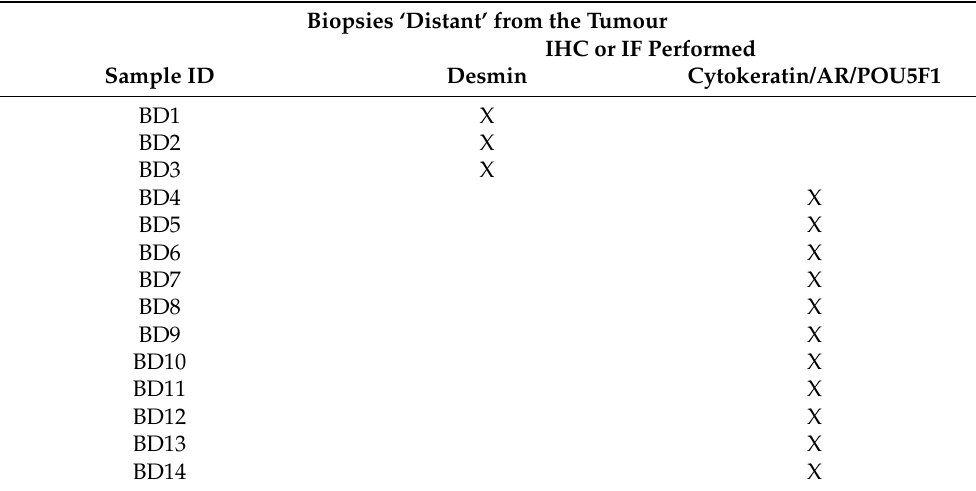
Table A6. Immunohistochemistry and Immunofluorescence performed on biopsies obtained in areas ‘distant’ to the seminoma tumour.